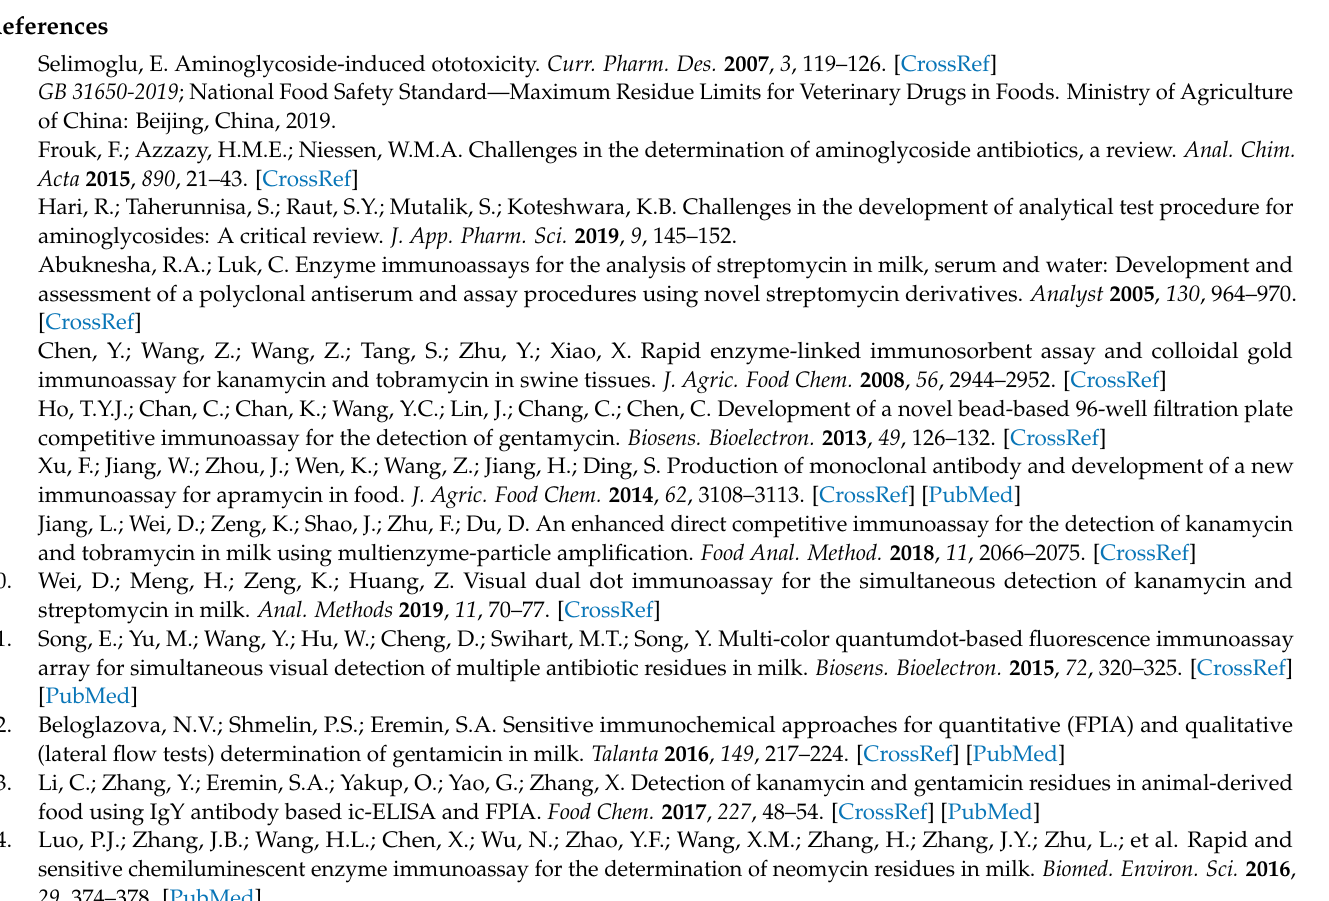
Figure S6: Binding kinetics of kanamycin with different concentrations of RpsL12-Rluc; Figure S7: Binding kinetics of isepamicin with different concentrations of